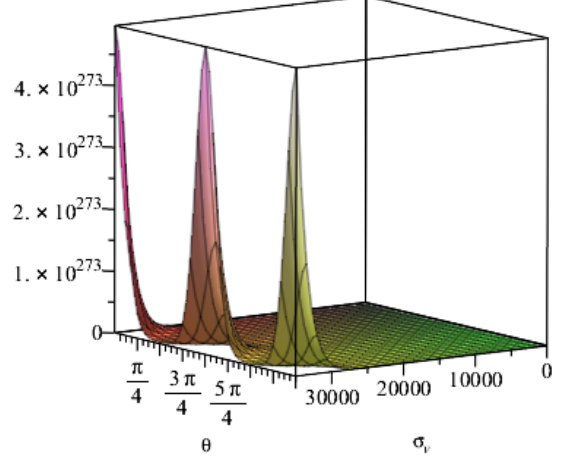
Figure 10. Relationship between the resistance value of the embedded carbon fibre and the radius of the tunnel.